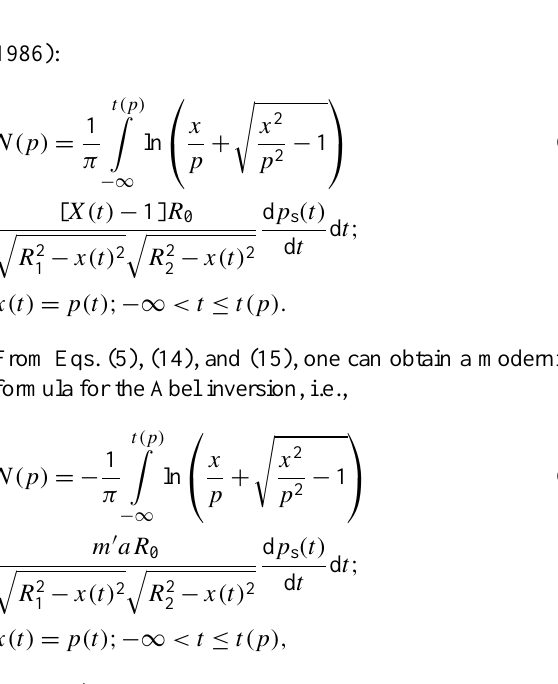
Figure 5. (a) Comparison of the refractive attenuations X a (h) , X p (h) found from the RO intensity and eikonal data at GPS frequency F1 (curves 1 and 2, respectively). (b) The amplitudes A a ,A p of analytical signals corresponding to the variations of the refractive attenuations 1 − X a (h) and 1 − X p (h) (curves 1 and 2), respectively. (c) Location of the first layer using amplitudes A a ,A p . (d) Vertical profiles of the gradients of electron density in the